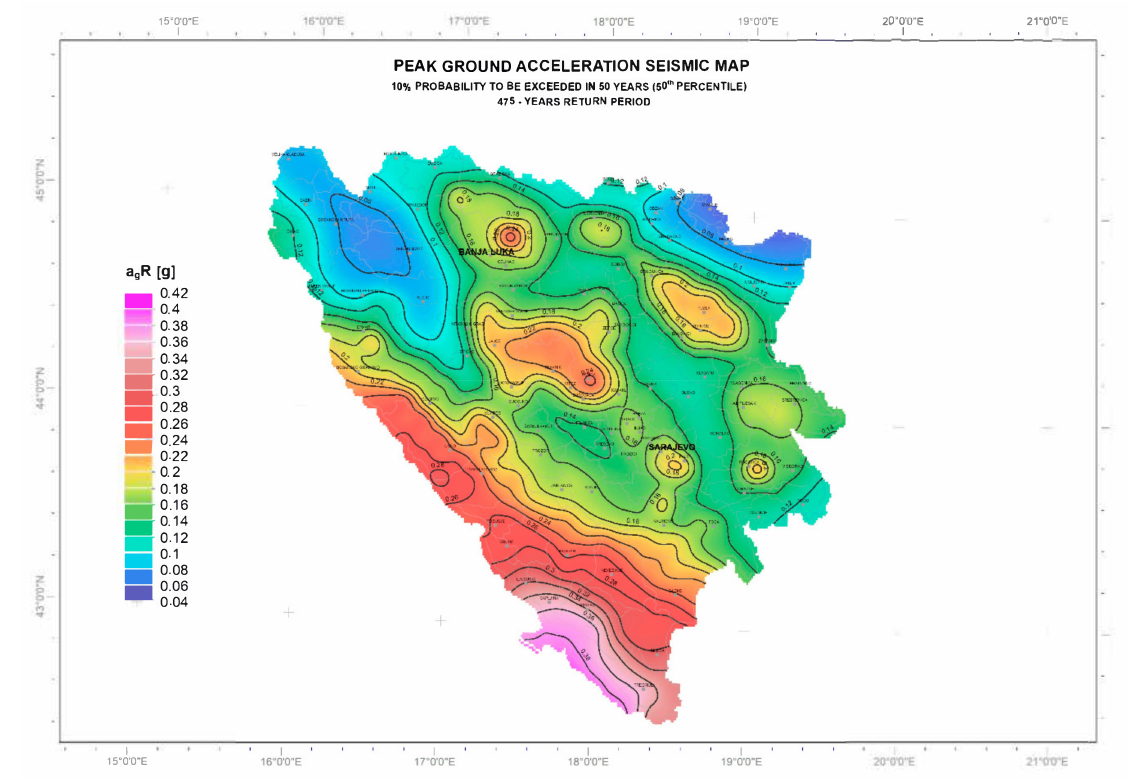
Figure 1. Seismic hazard map for Bosnia and Herzegovina in terms of peak ground acceleration (PGA) (475 years return period)